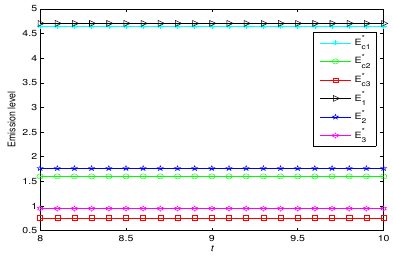
Figure 1. The emission levels of the cooperative and noncooperative transboundary pollution problems in Wanzhou District, Kaizhou District and Yunyang County.